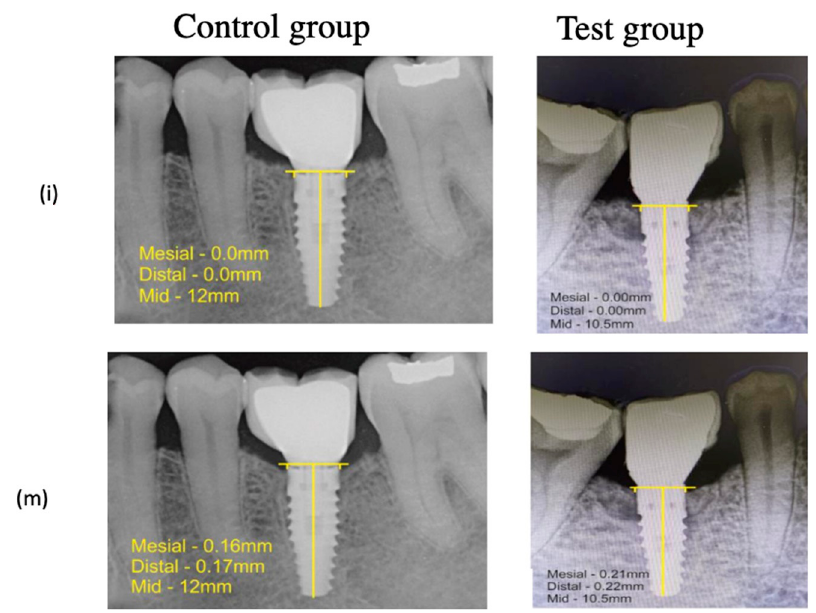
Figure 4. Measurement of Mean Crestal Bone Level—( i ) Immediately Post functional Loading, ( m ) 1 year Post functional Loading.